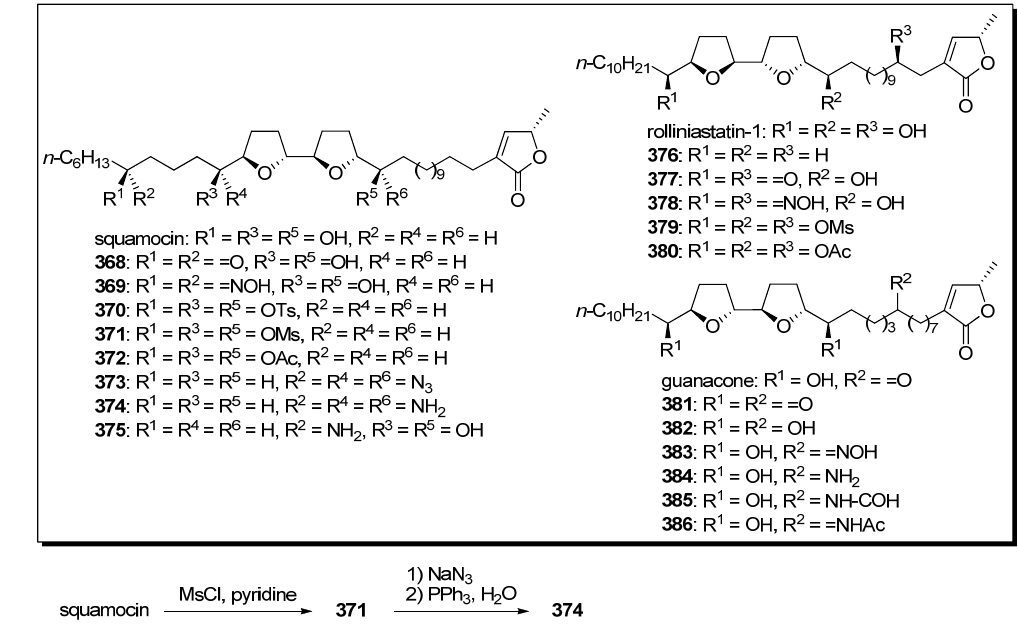
Table 28. Inhibitory potency against complex I and cytotoxicity against cancer cell lines.